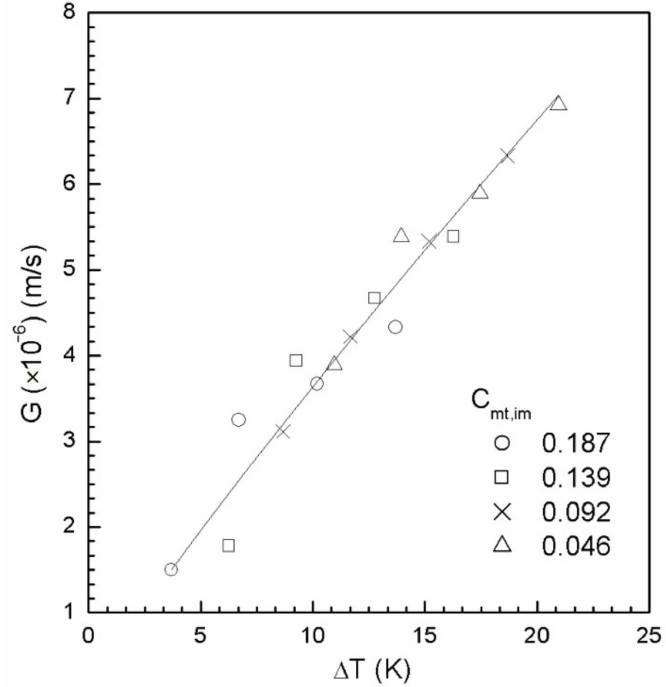
Figure 4. The dependence of G on ∆ T for various C mt,im .